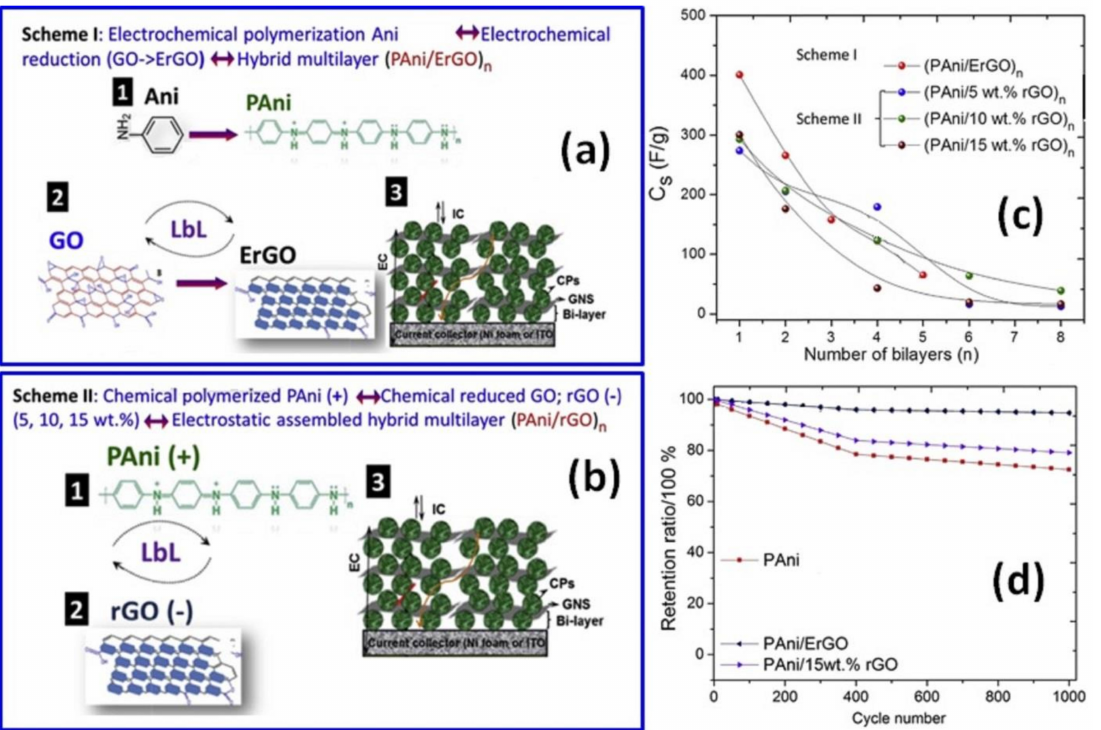
Figure 7. Preparation of layer-by-layer (LbL) assembled hybrid films of PANI with GO and ErGO nanosheets on ITO substrates designated as Scheme I ( a ). Preparation of electrostatic LbL hybrids of PANI with different rGO wt% nanosheets on ITO substrates by Scheme II ( b ). Specific capacitance for (PANI/ErGO) n and (PANI/rGO) n hybrids prepared using Scheme I and Scheme II with the number of bi-layers n from 1 to 8 ( c ). Plots of cycle life test of PANI, PANI/ErGO and PANI/15 wt% rGO ( d ) (Reprinted from [60], Copyright 2016, with permission of